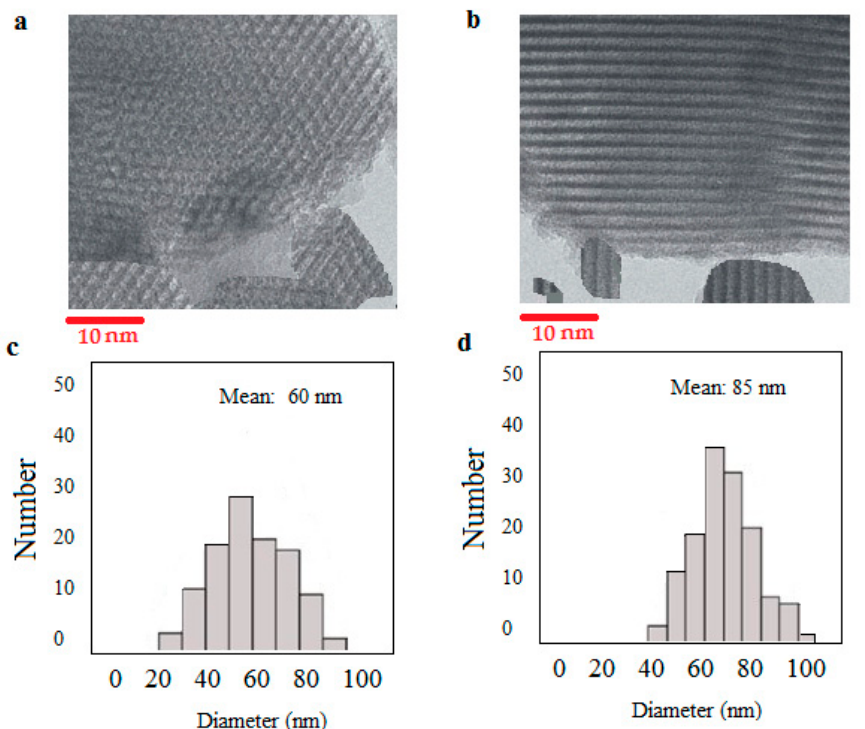
Figure 2. The average particle size for drug-free silica nanoparticles ( a ) and curcumin-loaded silica nanoparticles ( b ).